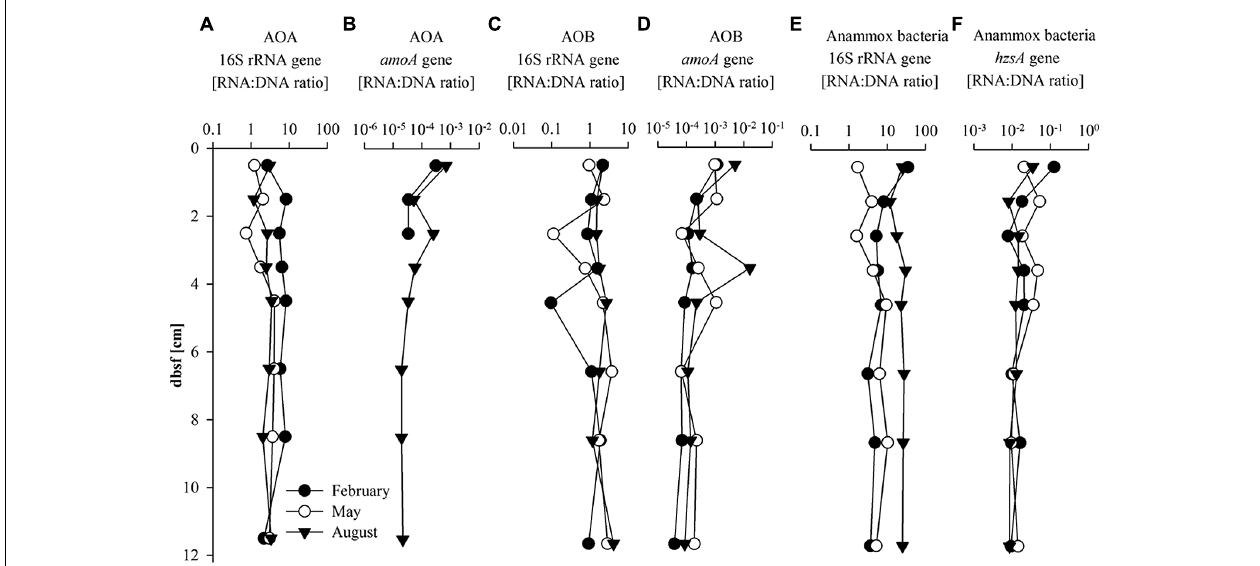
FIGURE 3 |Transcriptional activity given as RNA:DNA ratio of (A)AOA 16S rRNA gene; (B)AOA amo A gene; (C)AOB 16S rRNA gene, (D)AOB amo A; (E)Anammox 16S rRNA gene, and (F)Anammox bacteria hzs A gene with sediment depth (cm) below sea floor (bsf).